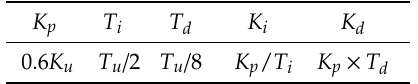
Table 2. Z–N tuning rules for the proportional–integral–derivative (PID)